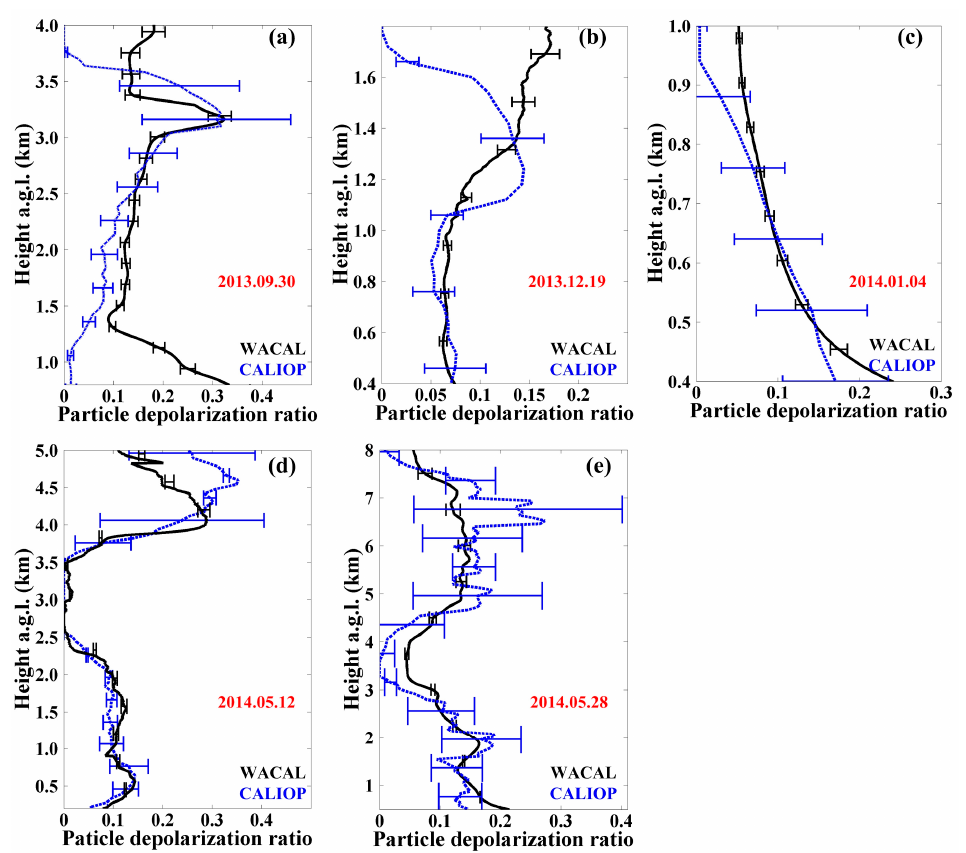
Figure 7. Comparisons of particle depolarization ratios from WACAL and CALIOP during the simultaneous observations on ( a ) 30 September 2013; ( b ) 19 December 2013; ( c ) 01 January 2014; ( d ) 12 May 2014 and ( e ) 28 May 2014, respectively.